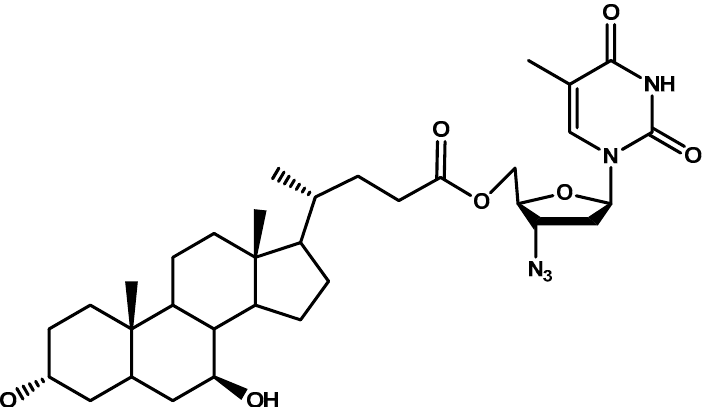
Figure 7. Chemical structure of AZT-UDCA prodrug.